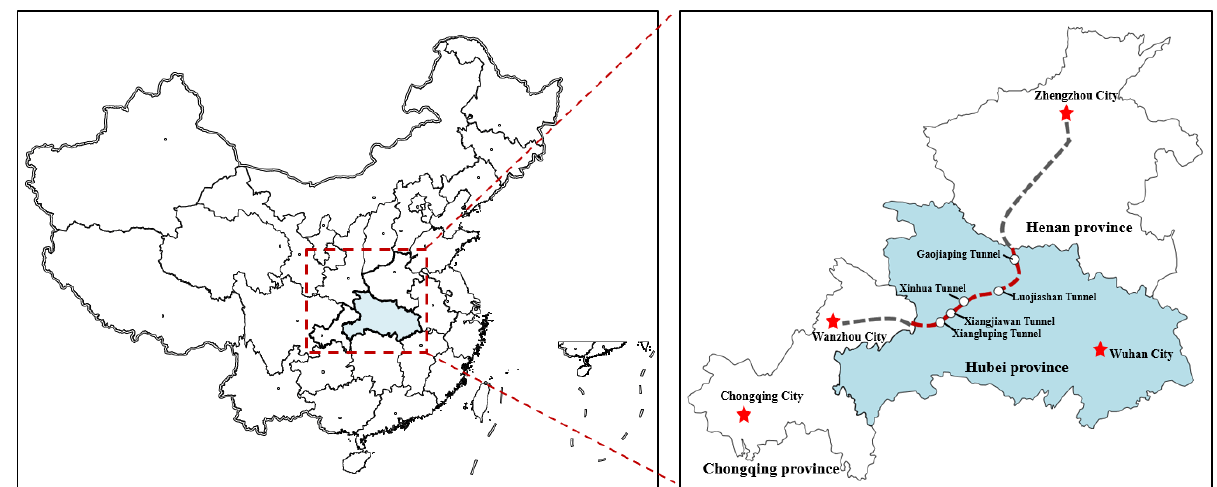
Figure 2. Locations of Zhengzhou–Wanzhou high-speed railway line and the tunnels where the samples were collected.